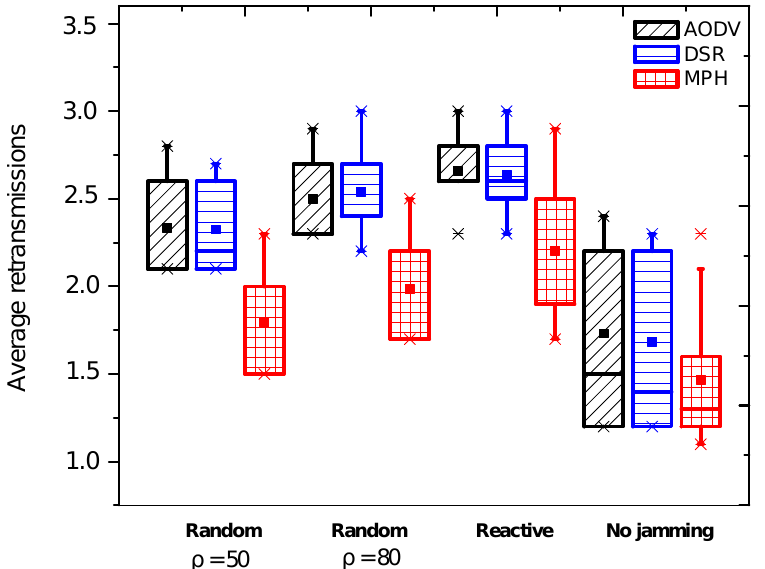
Figure 4. Average retransmissions when the jammer node is in the middle of the